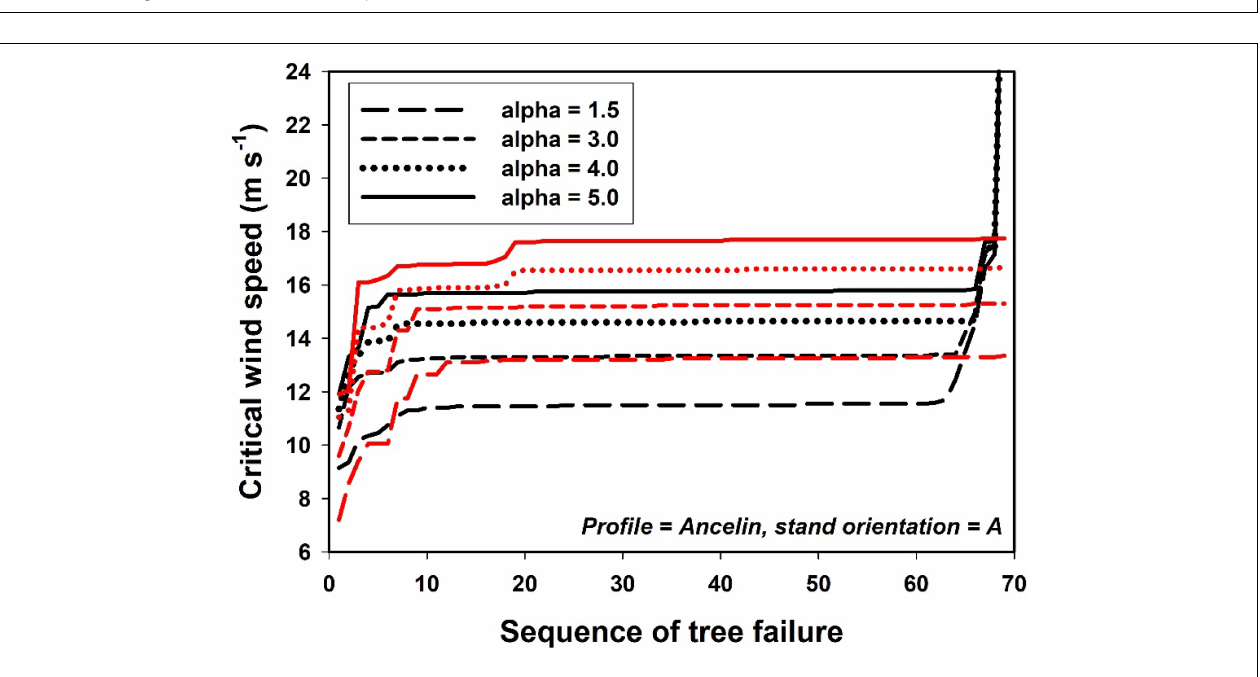
FIGURE 10 | Critical wind speed plotted against sequence of tree failure, for four values of attenuation coefficient (alpha), and contrasting combinations of within-stand parameters. Black lines = – indirect damage; – neighbor support; and – gaps. Red lines = + indirect damage; + neighbor support; +